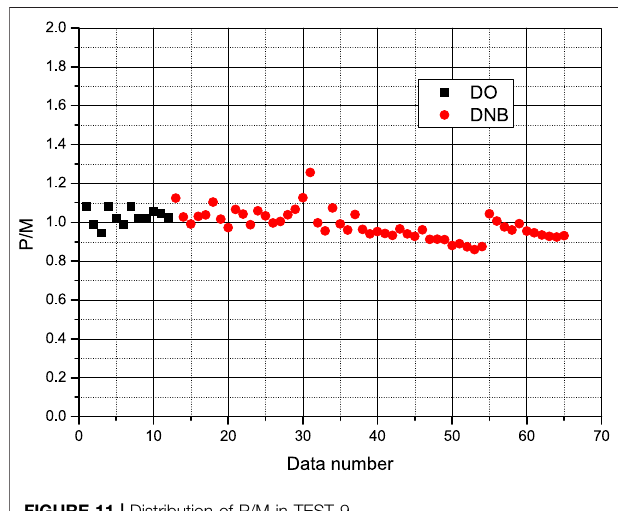
FIGURE 11 | Distribution of P/M in TEST 9.